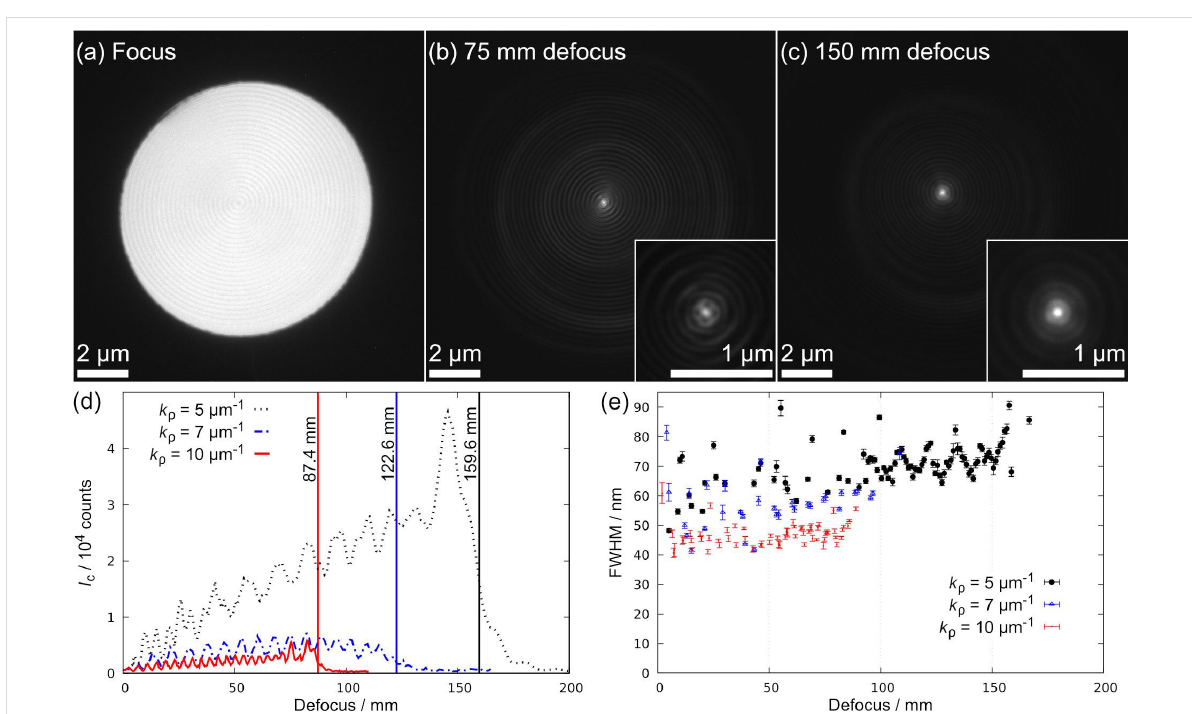
Figure 6: TEM images in LM mode of a PM placed in the object plane are shown in (a) to (c). (a) The image of the focused PM ( k ρ = 5 µm − 1 ) shows faint amplitude contrast. Defocusing the diffraction lens to (b) 75 mm and (c) 150 mm displays the preserved shape of a BB upon propagation. The in- tensity in (b) and (c) is shown on a logarithmic scale to visualize the bright center and the outer rings. The inserts display the center of the respective image. Since astigmatism was corrected for the planes shown in (a) and (c) the intermediate region in (b) shows slight astigmatism. (d) The measured intensity in the central peak is plotted against the nominal defocus. Vertical lines mark the measured values for z max for PMs with different k ρ . (e) FWHM of central maximum as a function of defocus for PMs with different k ρ . Error bars correspond to the fitting error of the Gaussian